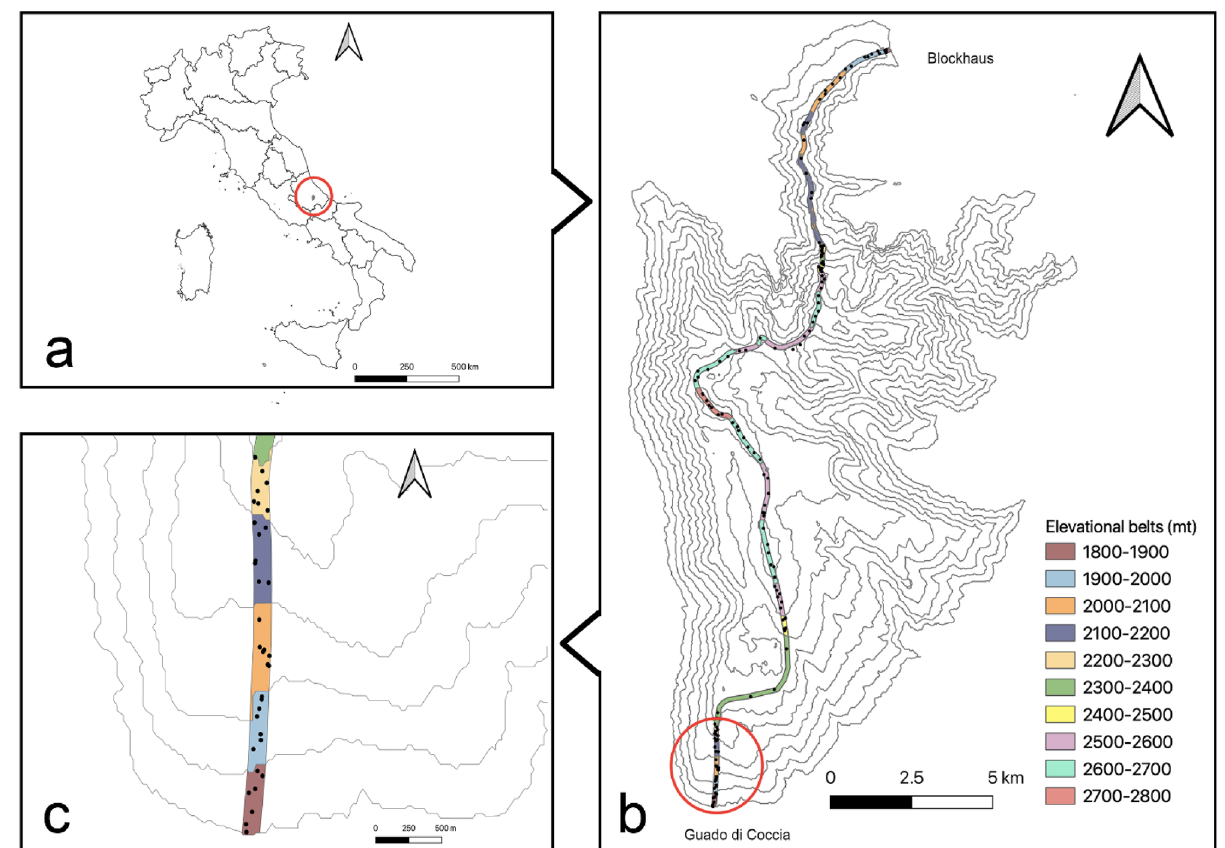
Figure 1. Location of the study area ( a ) and conceptualization of the sampling design ( b , c ). The elevational transect was split into ten 100 m belts ( b ). In each belt, 7 plots of 100 × 100 cm were randomly selected ( c ). Figure was produced using the open-source software QGIS 3.10.12 (https ://www.qgis.org) and assembled using Adobe Photoshop CC 2018. In particular, figure ( a ) is based on the shapefiles freely available on the ISTAT (Istituto nazionale di statistica) website: https ://www.istat .it/it/archi vio/22252 7. The contour line in figure ( b ) were calculated using Contour function available in QGIS 3.10 and using a 10 m resolution DTM